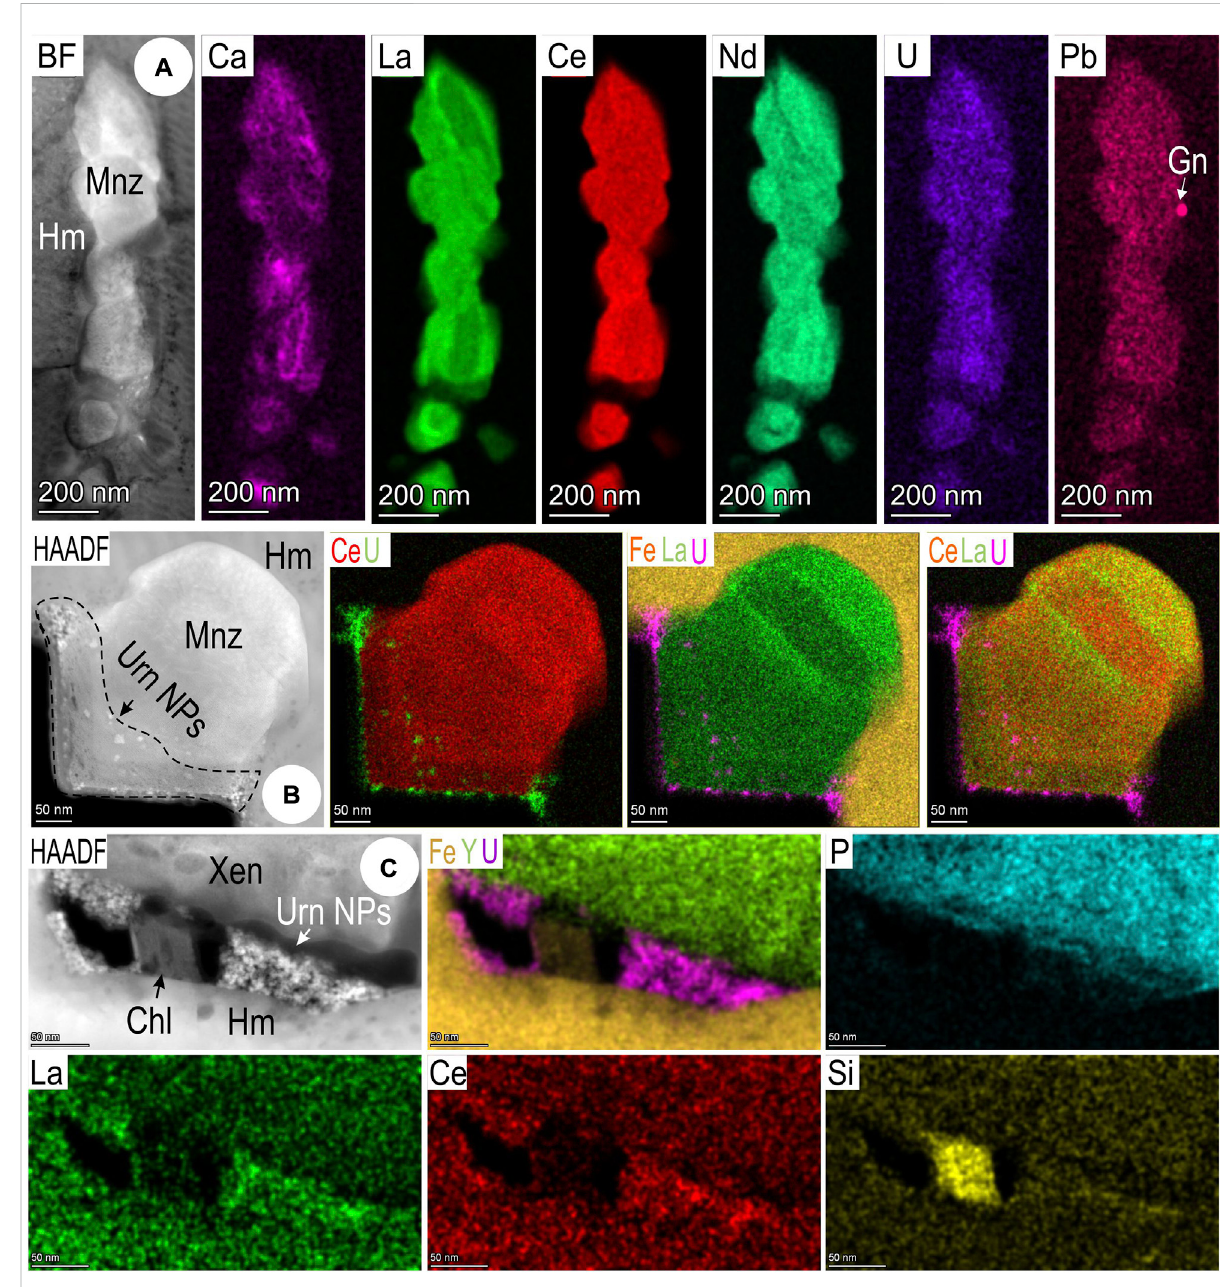
FIGURE 12 ImagesandSTEMEDSelementmapsofmonazite(Mnz)particles (A,B) anduraninite(Urn)NPs (C) inhematite(Hm)fromsample3Ta(maps3 –